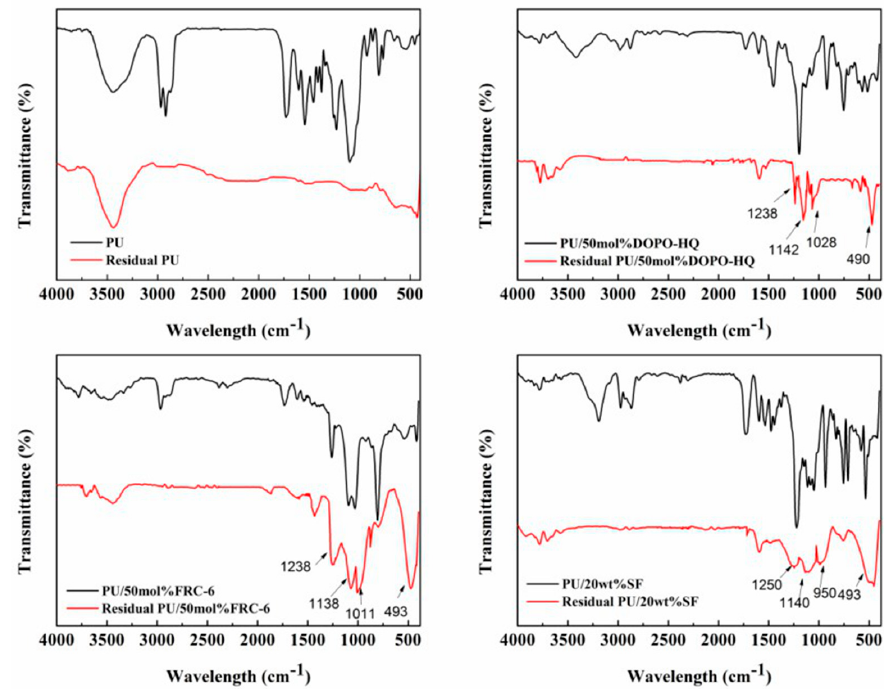
Figure 3. The FTIR spectra of the carbon residues of PU, PU/DOPO-HQ, PU/FRC-6, and PU/DOPO-SF.